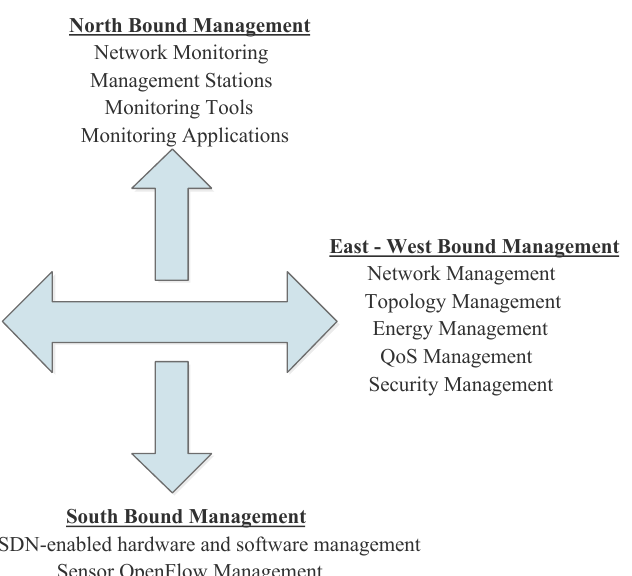
Figure 5. SDN-based management abstractions for